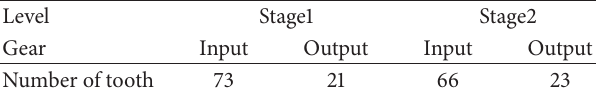
Table 2: Parameters of the parallel-stage gear. Level Stage1 Stage2 Gear Input Output Input Output Number of tooth 73 21 66